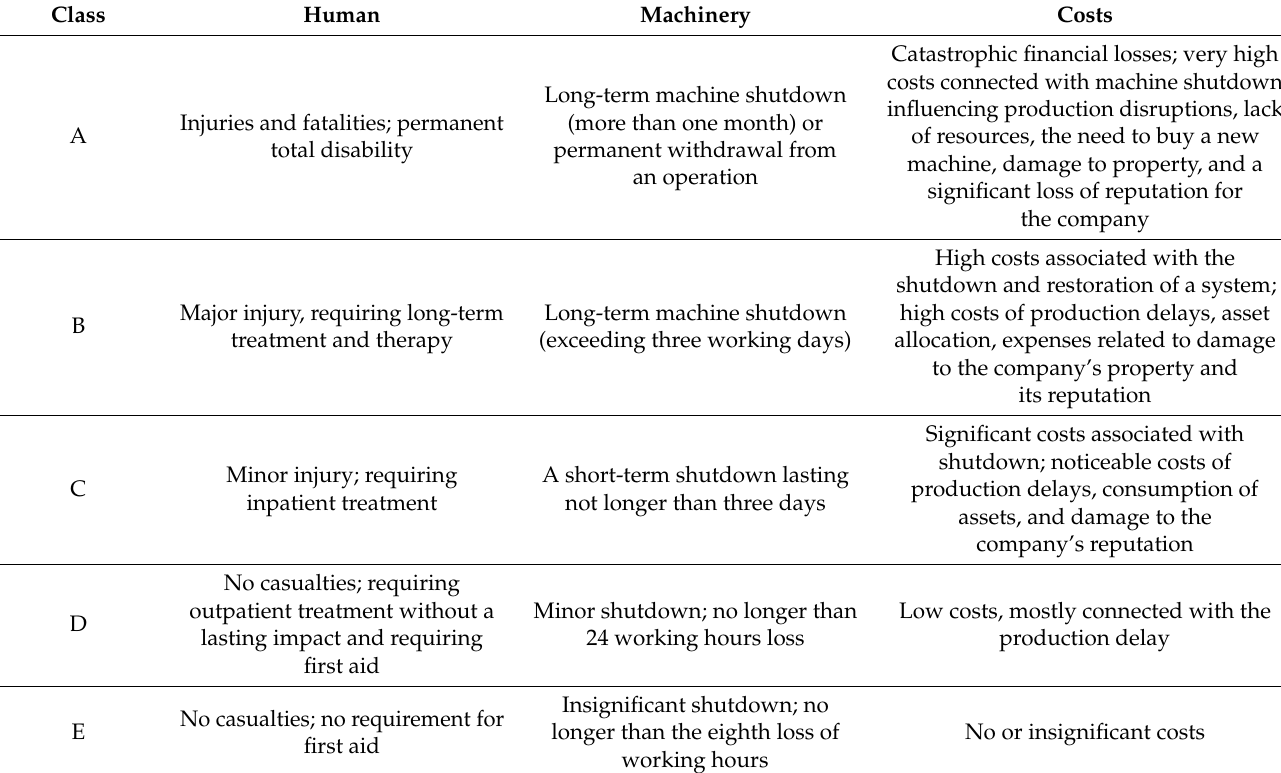
Table 3. Class of attention with consequences